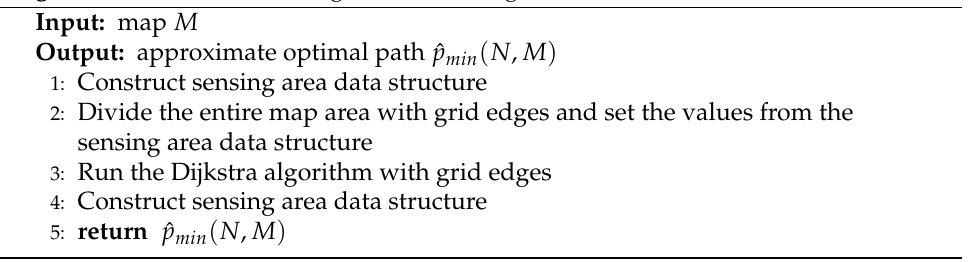
Algorithm 2: An enhanced algorithm with segment trees.